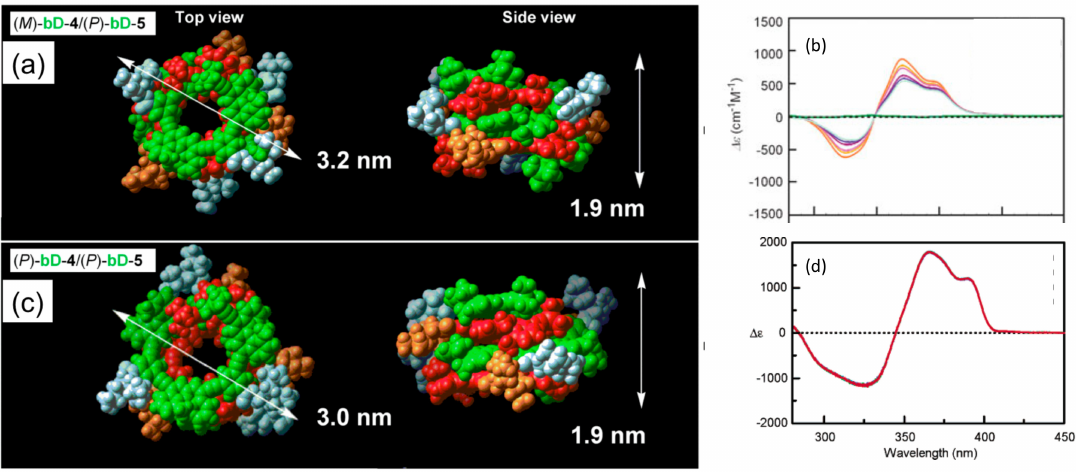
Figure 13. Calculated structures ( a ) and CD spectra ( b ) of hetero-double-helix derived from ( P )-tetramer/( M )-pentamer; calculated structures ( c ) and CD spectra ( d ) of homo-double-helix derived from ( P )-tetramer/( P